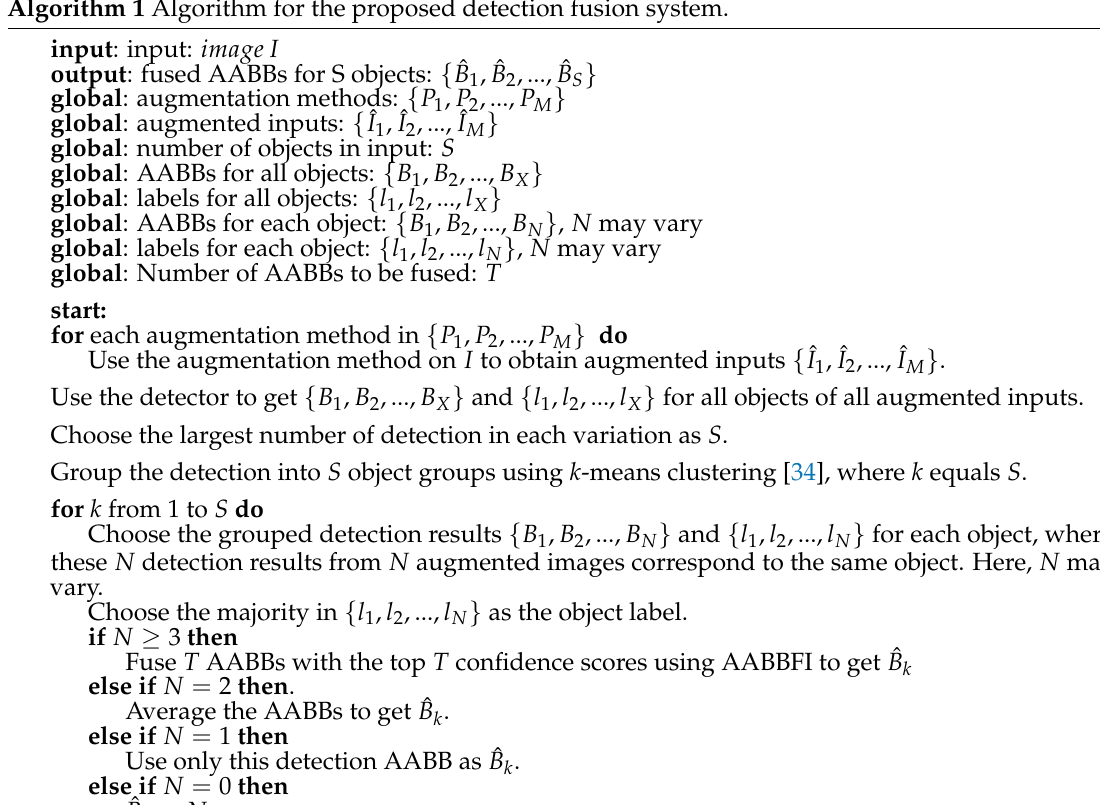
Figure 2. Proposed system for detection fusion. Algorithm 1 Algorithm for the proposed detection fusion